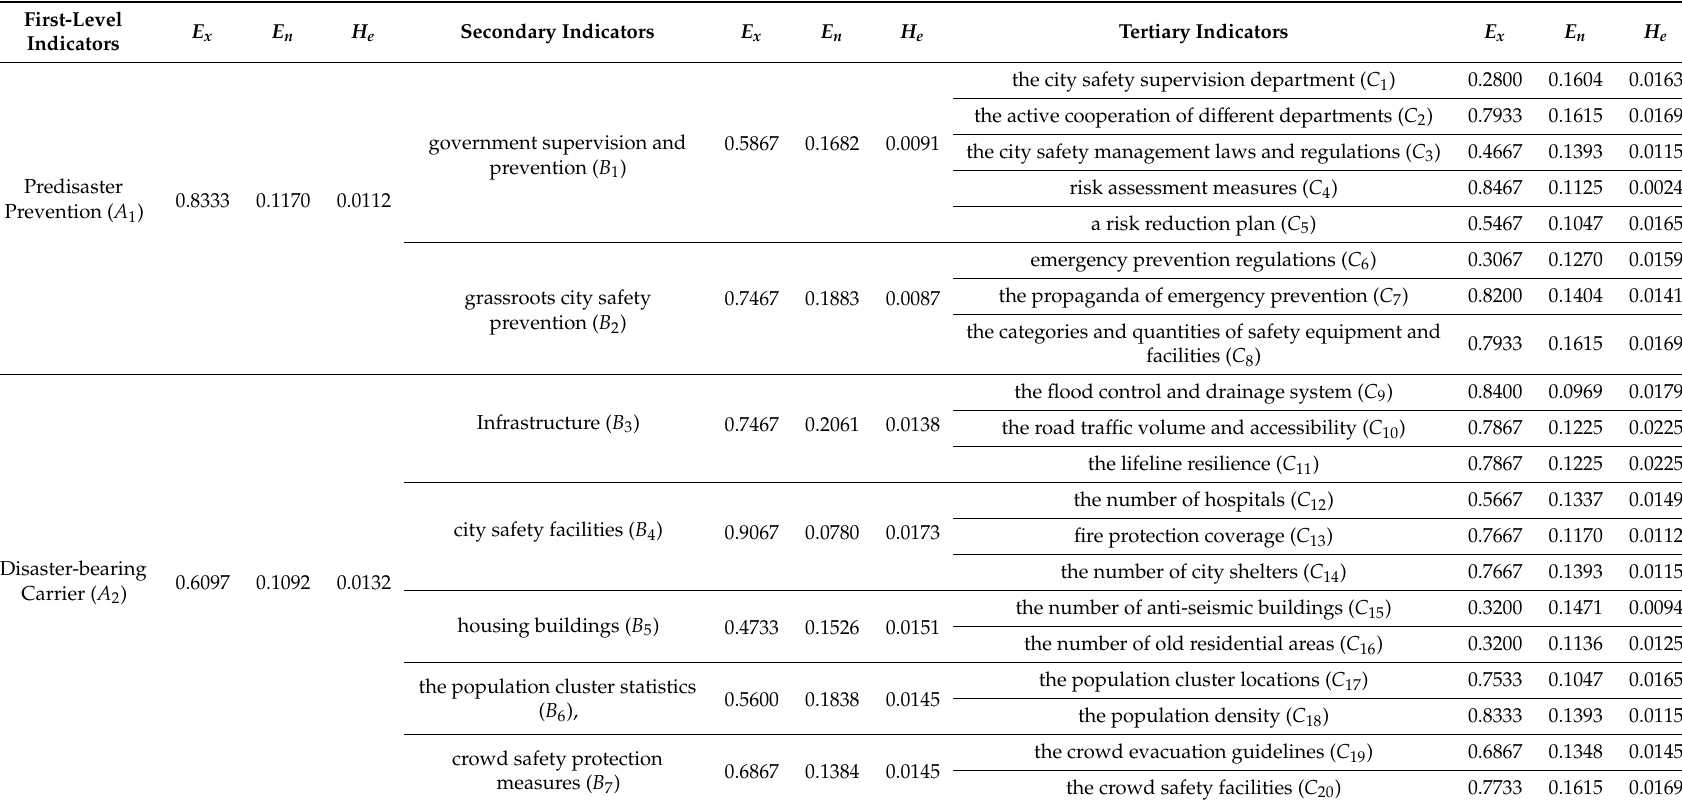
Table 2. Indicators’ digital